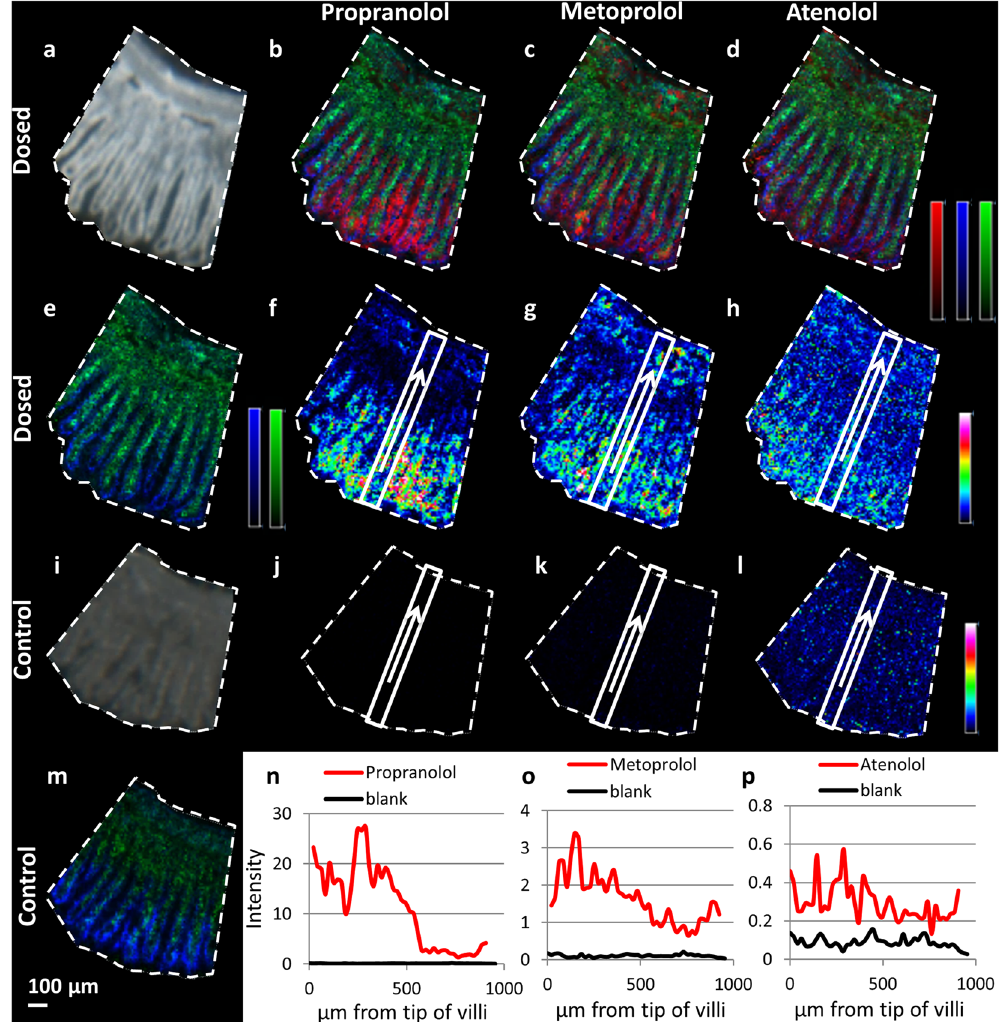
Figure 3. Distribution profiles of the three selected drugs in rat small intestine following oral dosing. ( a ) Scanned photo of tissue 30 cm distal from the pyloro-duodenal junction, collected 20 min post administration (10 µ mol/kg). ( b–d ) Ion distribution image of drug (red) together with two endogenous compounds used as villi markers (green m/z 772.6, blue m/z 804.6); ( b ) propranolol (m/z 260), ( c ) metoprolol (m/z 268), ( d ) atenolol (m/z 267). ( e ) Ion distribution image of two villi markers (green m/z 772.6, blue m/z 804.6) on dosed tissue. ( f–h ) Ion distribution image of drug represented by a rainbow colour. The rectangle areas and arrows from villi tips to submucosa mark the area from which the compound abundance is transformed into the line graphs in panels n–p. ( f ) Propranolol (m/z 260), respective line graph red line in panel n. ( g ) metoprolol (m/z 268), respective line graph red line in panel o. ( h ) atenolol (m/z 267) respective line graph red line in panel p. ( i ) Scanned photo of control tissue, not dosed with compound. ( j–l ) Ion distribution images of compounds propranolol ( j , m/z 260), metoprolol ( k , m/z 268), atenolol ( l , m/z 267) with rectangles indicating the area from which the intensity was derived to produce line graphs (blanks in panels n-p respectively). ( m ) Ion distribution image two villi markers (green m/z 772.6, blue m/z 804.6) on control tissue. ( n–p ) line graphs of compound exposure along the crypt-villus axis in dosed (red) and non-dosed (black) tissue, ( n ) propranolol, ( o ) metoprolol, p ) atenolol. The intensity levels are extracted as average intensity from the tip towards the base of the villi, from the area marked with rectangles in panels f–h (dosed) and ( j–l ) (control). ( b–e , m ) are represented by monochrome colour scales; red - scaled to 60% of max intensity, green - scaled to 40% of max intensity, blue - scaled to 30% of max intensity. ( f–h and j–l ) are represented by a rainbow colour scaled to 60% of max intensity for each individual m/z. Images were acquired at 10 µ m spatial resolution. Scale bar 100 µ